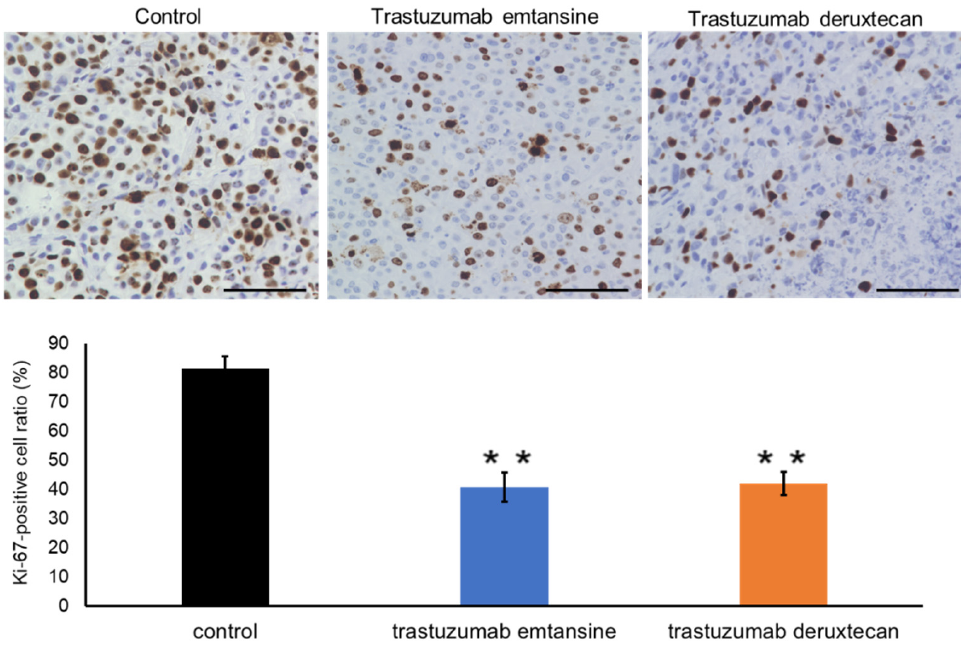
Figure 4. The ratio of Ki-67-positive cells is lower in the HER2-targeted ADC-treated cells than in the control tumor cells. EMPD tumors were treated with HER2-targeted ADCs (trastuzumab emtansine or trastuzumab deruxtecan). After 48 h, the tumors were extracted and were assessed by Ki-67 staining. Upper: Representative images of Ki-67 staining (scale bar = 100 µ m).Lower: The ratio of Ki-67-positive cells was examined (columns, mean percentage of Ki-67-positive cells, n = 3, determinations based on examination of 100 tumor cells; bars, SD). ** p < 0.01; compared to control tumors, by t -test.